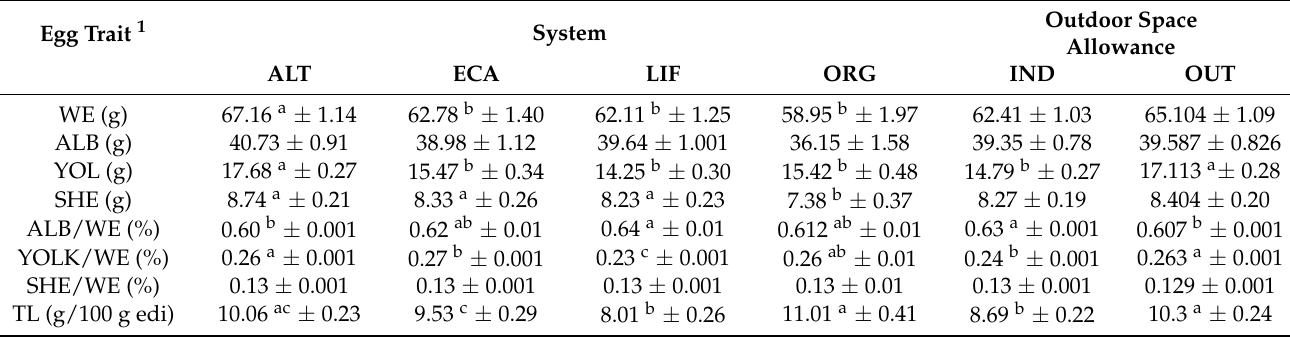
Table 2. Physical parameters and yolk total lipid in eggs from different housing systems (SYSTEM) and outdoor space allowance (OSA) (LS means ±